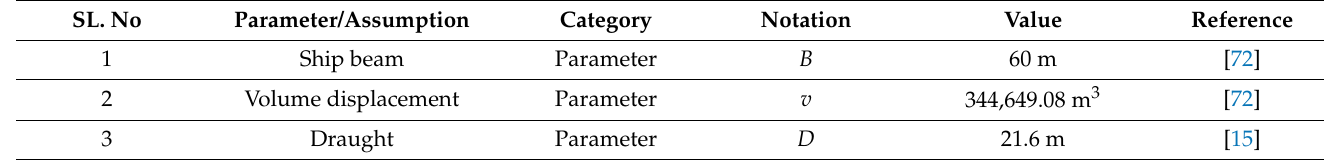
Table A1. Parameters and Assumptions of ‘Baltic